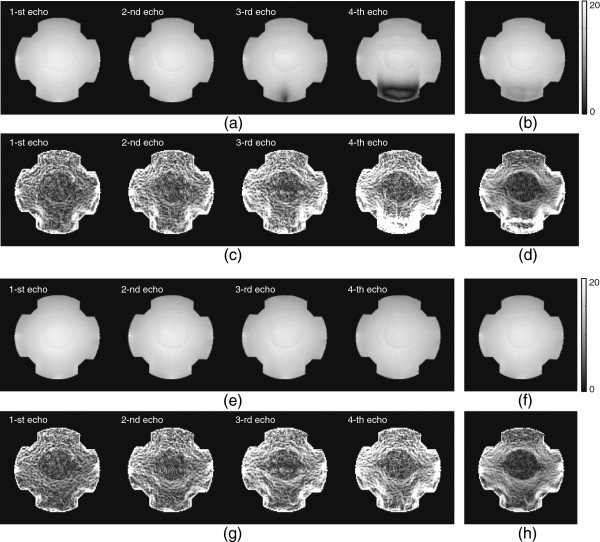
Iteratively updatedT2∗ weighted magnitude and magnetic flux densityBz images usingP0∪P+ withNc=5 andNc=10.a) and e) recoveredT2∗ weighted magnitude image at each echo timeTEm,m=1,2,3,4, with Nc=5 and Nc=10, respectively. b) and f) combinedT2∗ weighted magnitude image using the recovered magnitude image at each echo time with Nc=5 and Nc=10, respectively. c) and g) recovered Bz image at each echo timeTEm,m=1,2,3,4,with Nc=5 and Nc=10, respectively. d) and h) weighted Bz image using multiple Bz image at each echo time with Nc=5 and Nc=10, respectively.